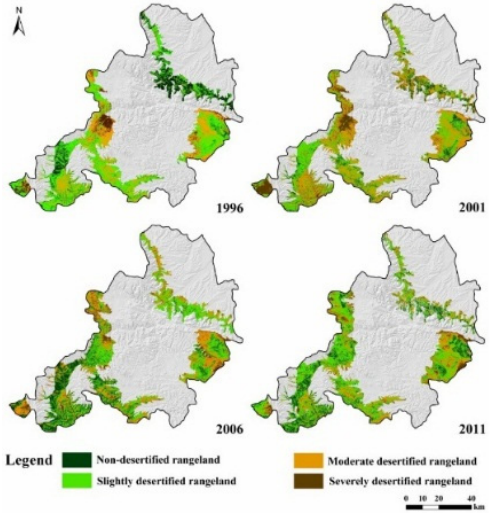
Figure 5. Rangeland degradation from 1996 to 2011 for the Linxia rangeland.